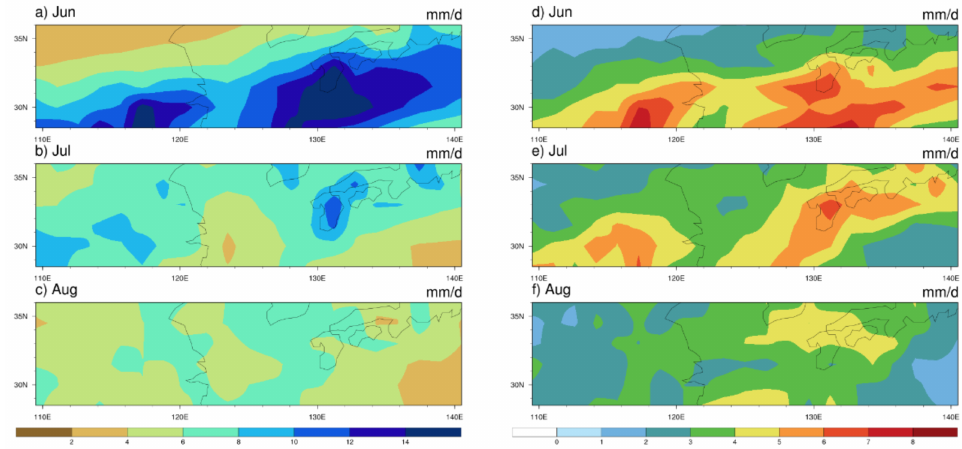
Figure 1. Climatological mean ( a – c ) and standard deviations ( d – f ) of precipitation for each month in summer from 1991 to